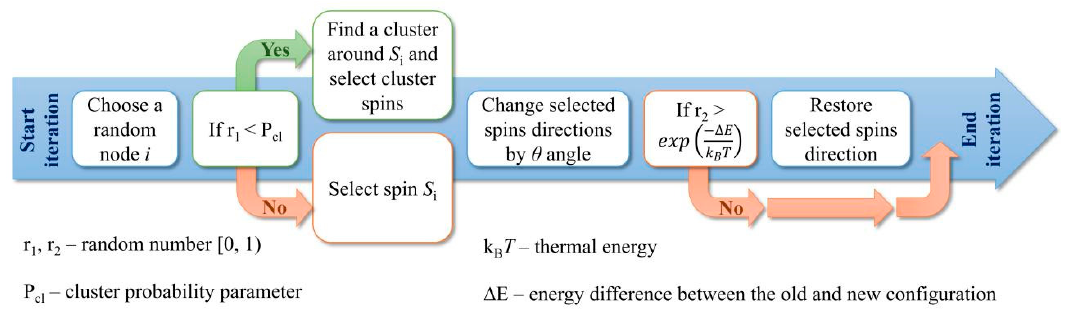
Figure 2. Flowchart of single iteration steps used in this paper.